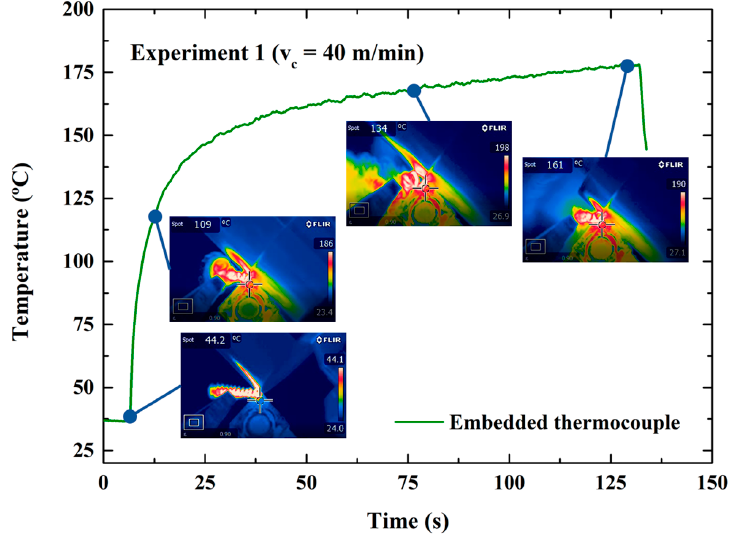
Figure 7. Example of IR thermographs obtained for experiment 1 over some machining times.